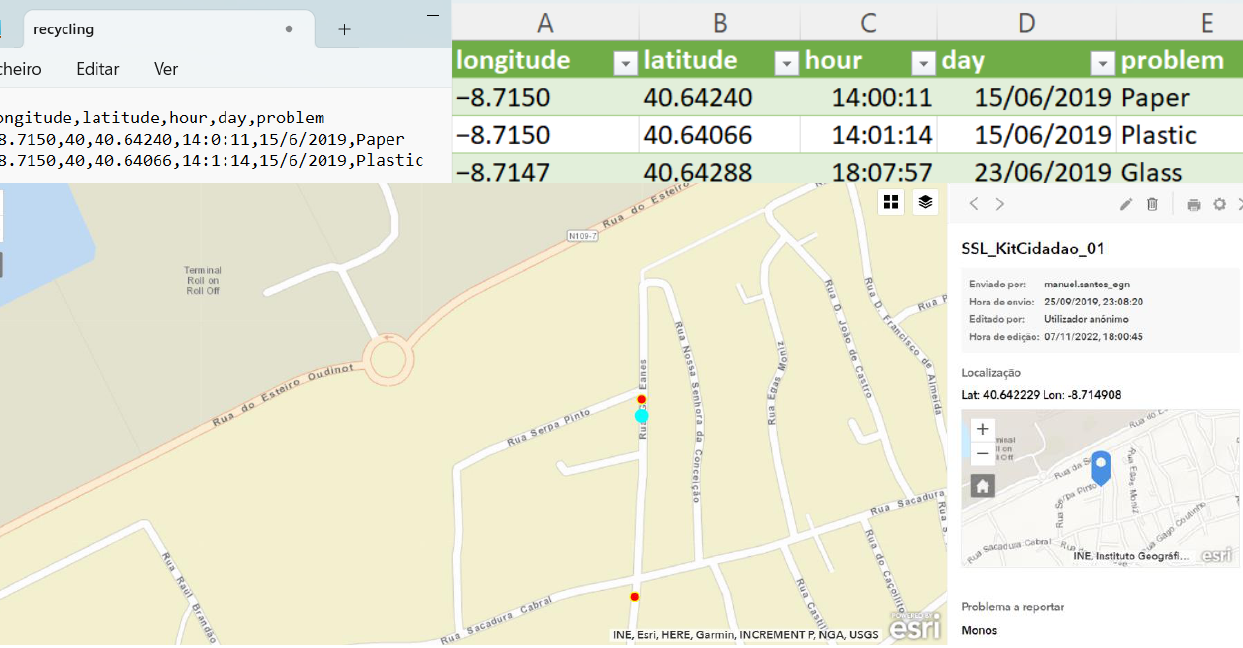
Figure 19. FTP server and Survey123 map with reported issues. Red and blue dots correspond to the GPS location of each collected waste.